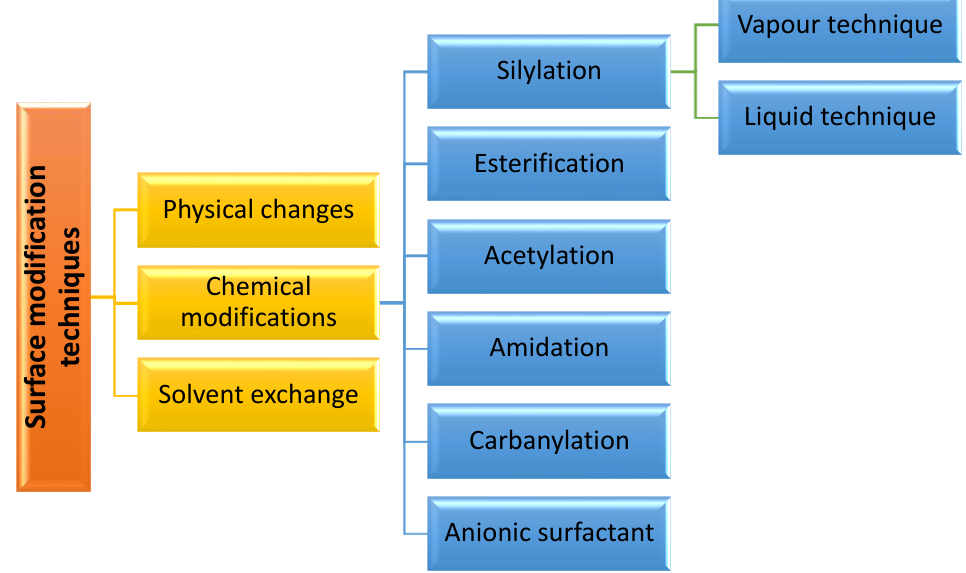
Figure 2. Summary on the surface modification technique for cellulose-based fillers.